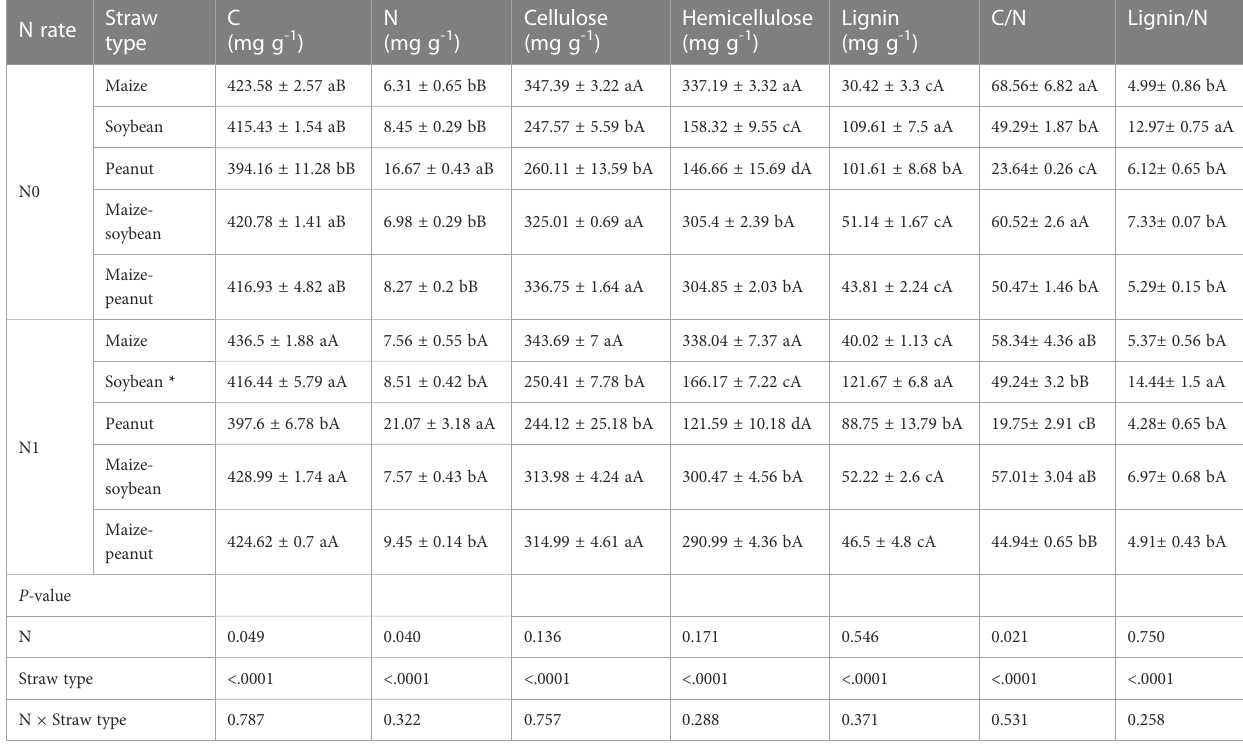
TABLE 1 Initial quality traits of straw types (monoculture and mixture) from the different N addition treatments in experiments I –